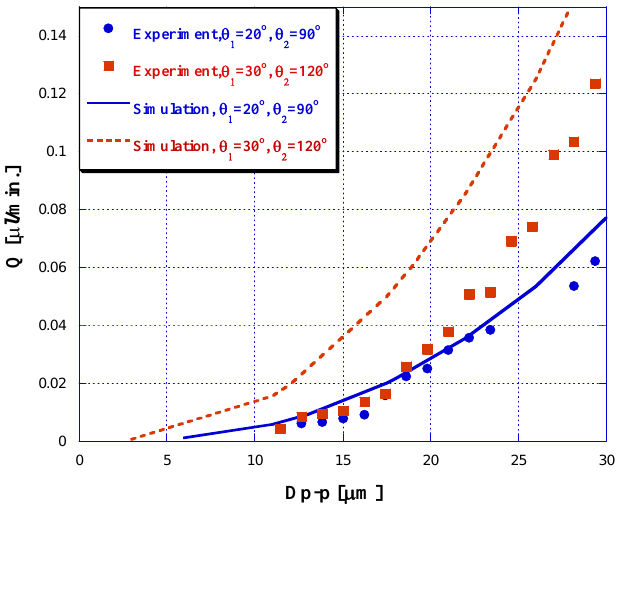
Figure 13. Experimental and simulation analysis comparison chart with expansion valve = 30° and θ = angles of θ 1 2